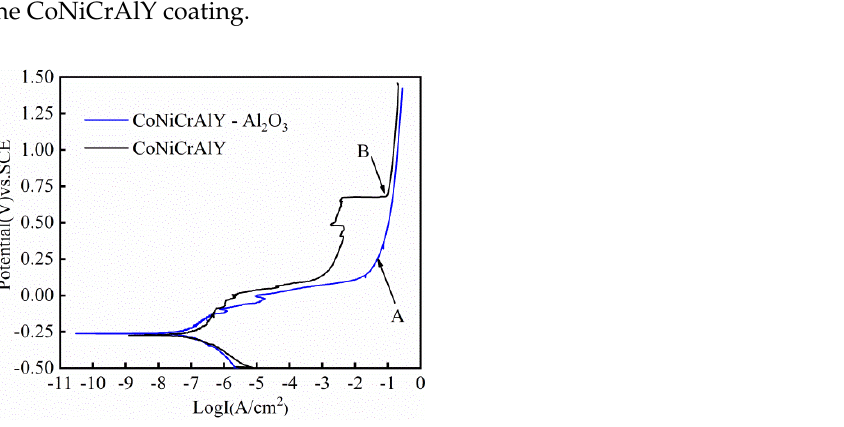
Figure 4. Potentiodynamic polarization curves of the HOVF sprayed CoNiCrAlY coating and CoNiCrAlY-Al 2 O 3 coating. Table 6. Electrochemical parameters obtained from the potentiodynamic polarization curve of these